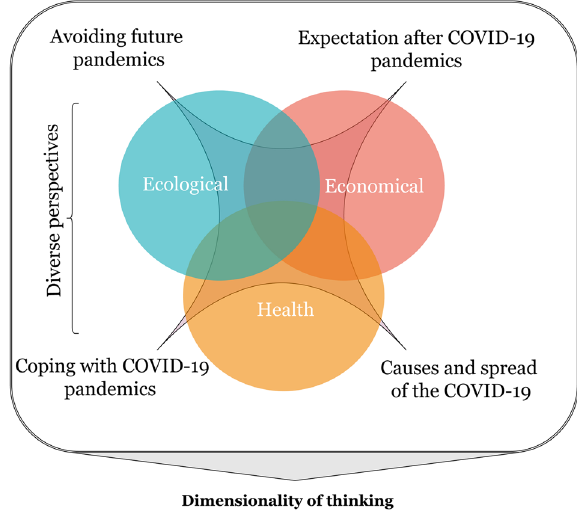
Fig. 1 Conceptual framework of the dimensionality of thinking about COVID-19